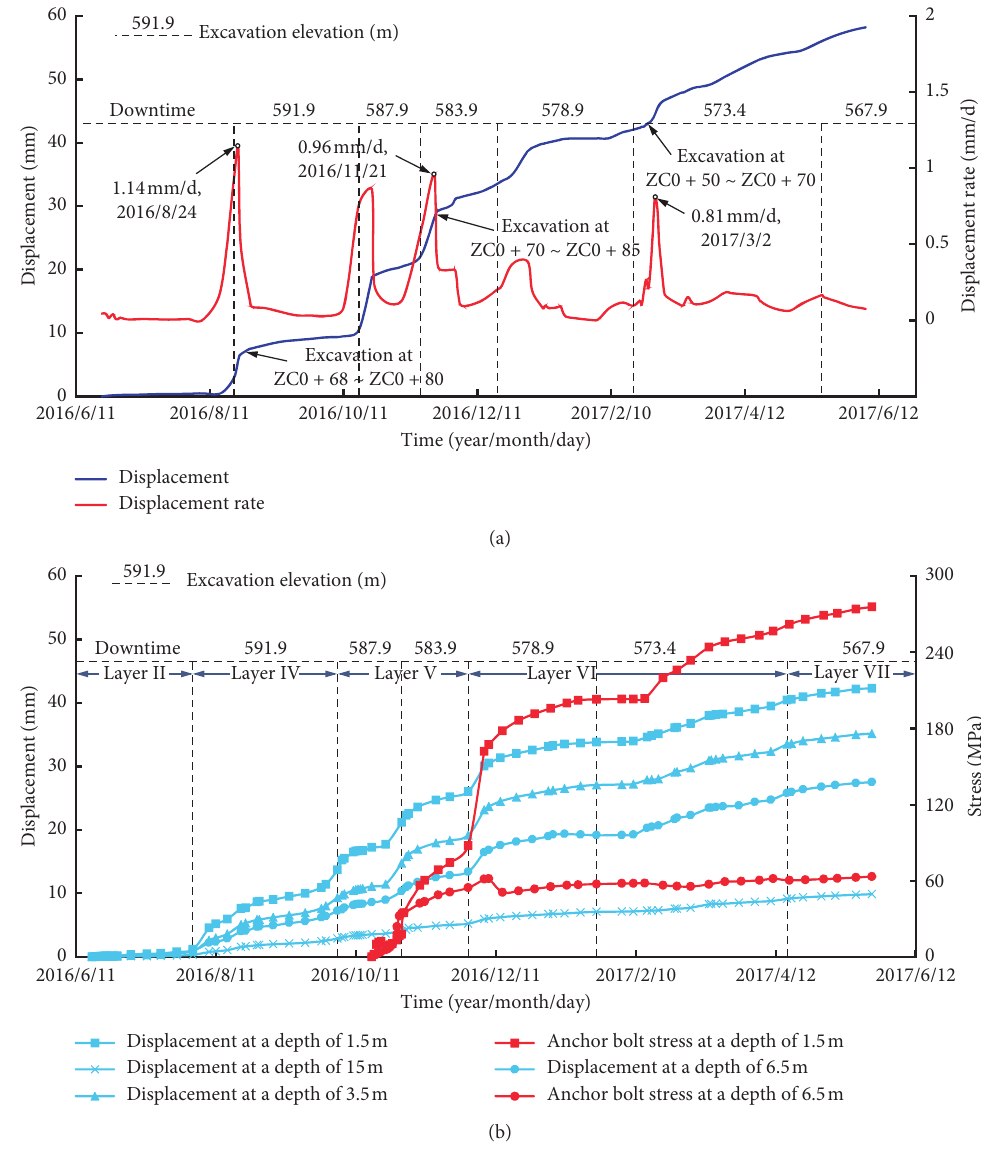
Figure 14: Monitoring result of the multipoint extensometer and anchor bolt: (a) displacement and displacement rate curves at stake ZC0 +77m; (b) displacement and anchor bolt stress curves at stake ZC0